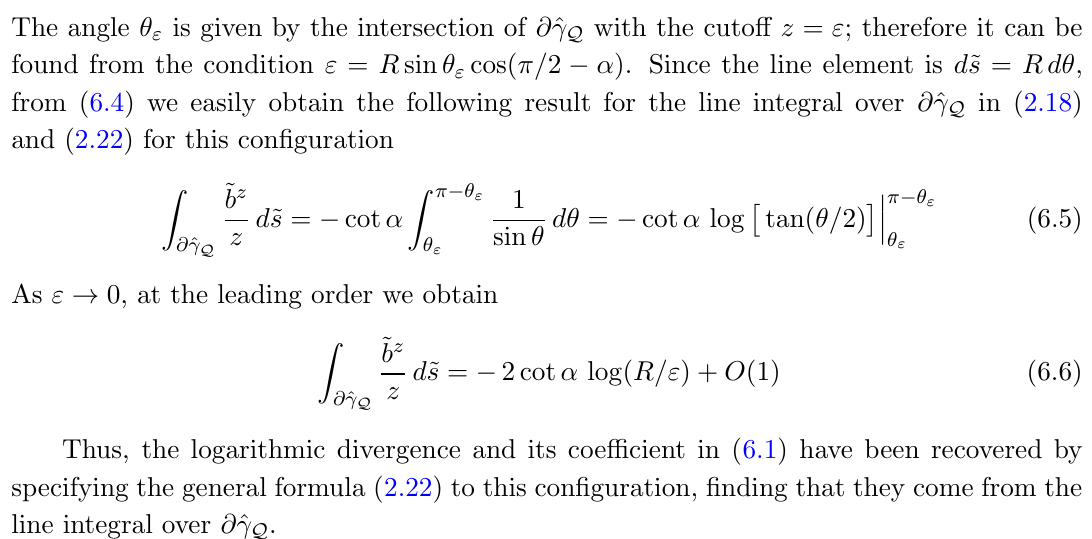
Figure 15 . Minimal surface ^ (cid:13) A anchored to the entangling edge (the red line) of an in(cid:12)nite wedge A adjacent to the (cid:13)at boundary, in the gravitational setup of section 2.2.1. The analytic results of [87] have been employed to plot these surfaces (see section 6.2). The green half plane is Q and the yellow plane corresponds to z = " , and they intersect ^ (cid:13) A along the green line and the yellow curve respectively. Left: ! = 0 : 2 and (cid:11) = (cid:25)= 4. Right: ! = 0 : 3 and (cid:11) = 2 (cid:25)=